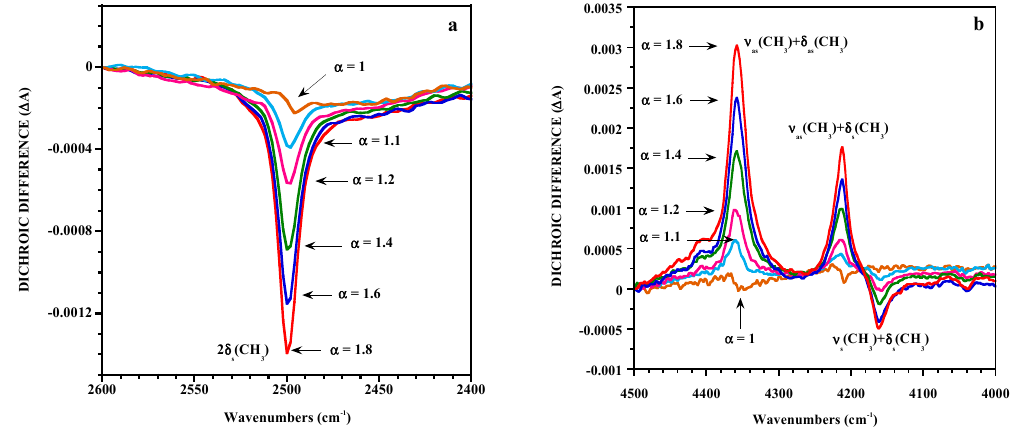
Figure 1. Strain dependence of the dichroic difference for a poly(dimethylsiloxane) (PDMS) film in the 2,400–2,600 cm − 1 (a) and in the 4,000–4,500 cm − 1 ( b ) regions. Reproduced with permission from [37].